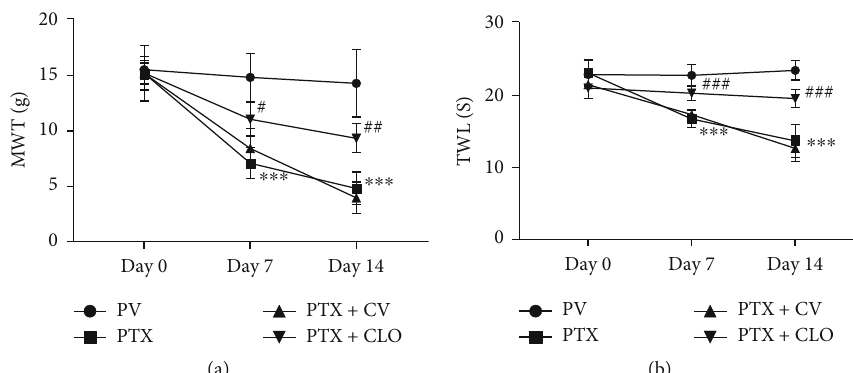
Figure 1: Pain behavioral assessment. (a) E ff ects of clodronate on mechanical withdrawal threshold (MWT) in PIPN rats. (b) E ff ects of clodronate on thermal withdrawal latency (TWL) in each group. Data are expressed as the mean ± SD ( n = 6 in each group). The results were analyzed using one-way ANOVA followed by the LSD post hoc test. ∗∗∗ P < 0 : 001 vs. VC group, # P < 0 : 01 , ### P < 0 : 001 vs. PTX +CV group. Abbreviations: PTX: paclitaxel; CLO: clodronate disodium